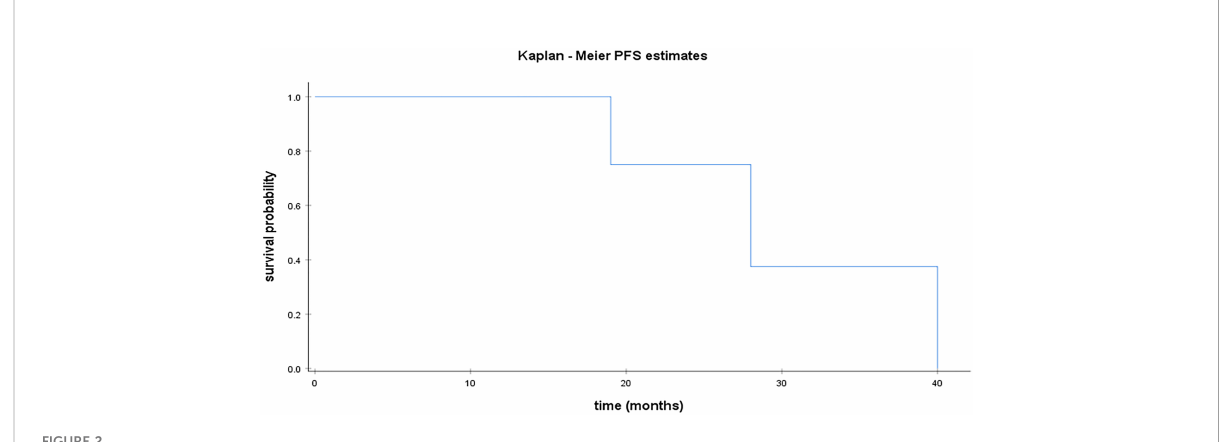
FIGURE 2 Kaplan Meier curve for OS in HGSC.